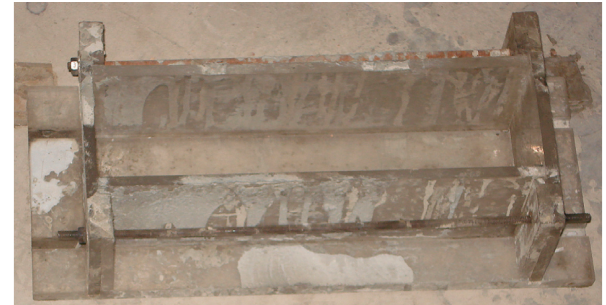
Figure 7: The glass mold for measuring free tensile